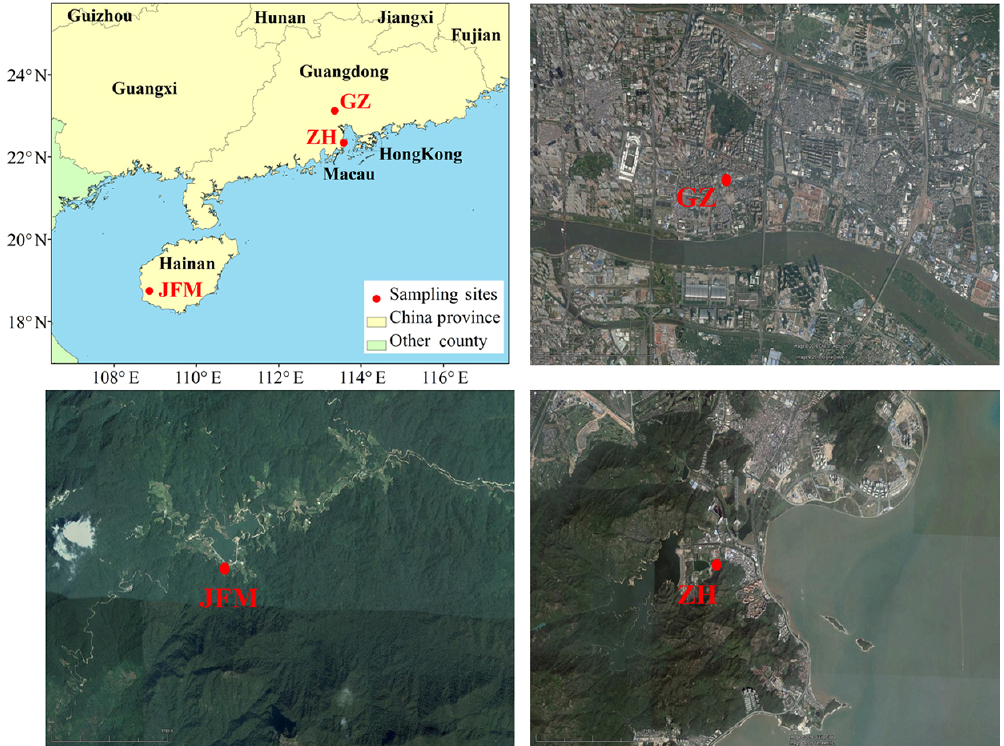
Figure 1. Location of sampling sites in southern China: GZ (Guangzhou), ZH (Zhuhai), and JFM (Jianfeng Mountain) and their surrounding